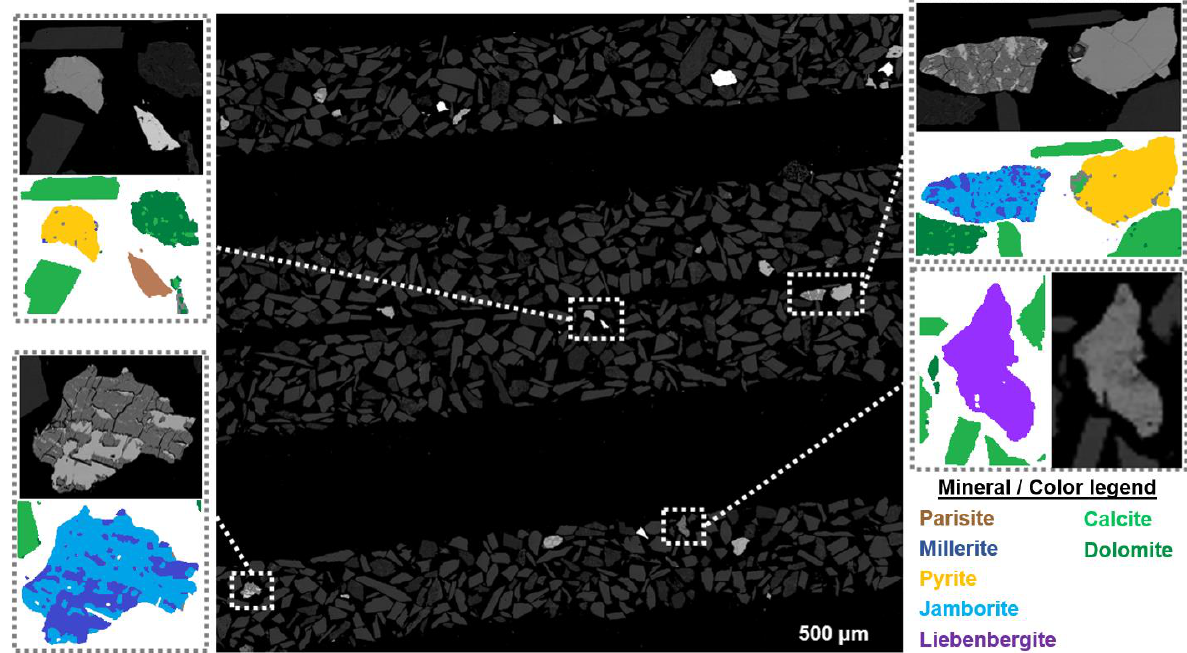
Figure 4. Overview of the electron backscattered image used for MLA characterization of the Carbonate sample. The most common phases and microstructures are magnified.